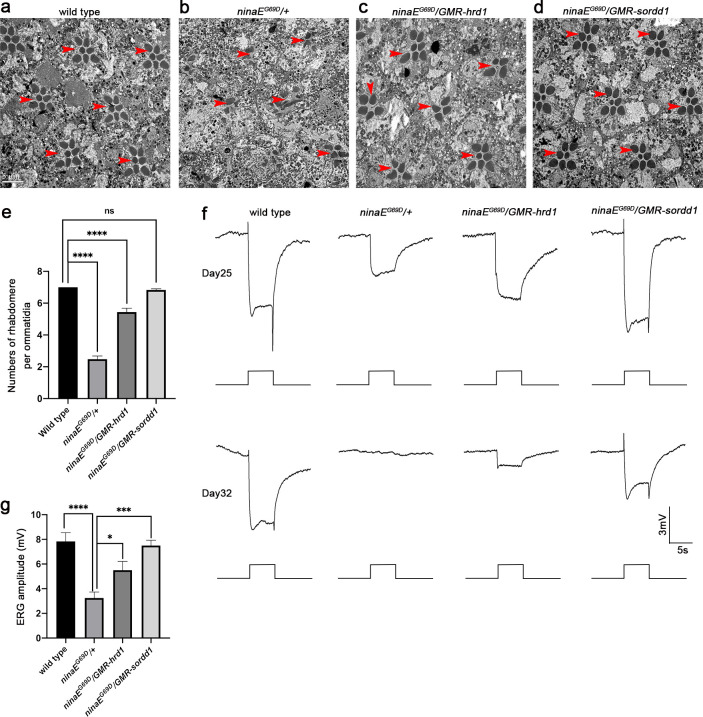
SORDD1 strongly suppresses retinal degeneration in the ninaEG69D model of adRP.(a-d) Representative TEM images of 25-day-old adult eye tangential sections of (a) wild type (canton S), (b) ninaEG69D/+, (c) ninaEG69D/GMR-hrd1 and (d) ninaEG69D/GMR-sordd1 flies. Rhabdomeres are indicated by red arrows. Scale bar, 5 μm. (e) Quantification of a-d, Error bars indicate SEM; sections from three individual flies of each genotype were used for quantification. ns, not significant, ****p<0.0001 (one-way ANOVA, Sidak's multiple comparisons test). (f) ERG recordings of 25-day-old and 32-day-old wild-type, ninaEG69D/+, ninaEG69D/GMR-hrd1 and ninaEG69D/GMR-sordd1 flies. Flies were exposed to a 5-s pulse of orange light after 1 min of dark adaptation. (g) Statistic results of the amplitude of ERG recordings of flies at age of 25 days, Error bars indicate SEM; n = 6, *p<0.1, ***p<0.001, ****p<0.0001 (one-way ANOVA, Sidak's multiple comparisons test). Red-eyed flies were raised under constant light conditions. All flies were in w+ background and were raised in 24 h constant light (~700 Lux) at 25°C.